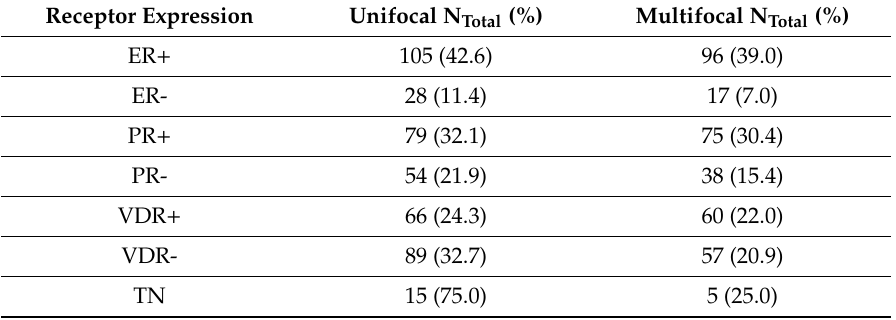
Figure 5. Immunohistochemical staining of ER and VDR after incubation with the primary antibody of the malignant breast cancer cells (25 × lens). ( A , B ) Immunohistochemical staining of ER in human BC. ( A ) An IRS ≤ 1 meaning ER-negative and ( B ) an IRS value ≥ 2 being ER-positive. ( C , D ) Immunohistochemical staining of VDR in BC. ( C ) An IRS ≤ 1 meaning VDR-negative and ( D ) an IRS value ≥ 2 being VDR-positive. Table 9. Patient characteristics of the total collective, sample size of receptor